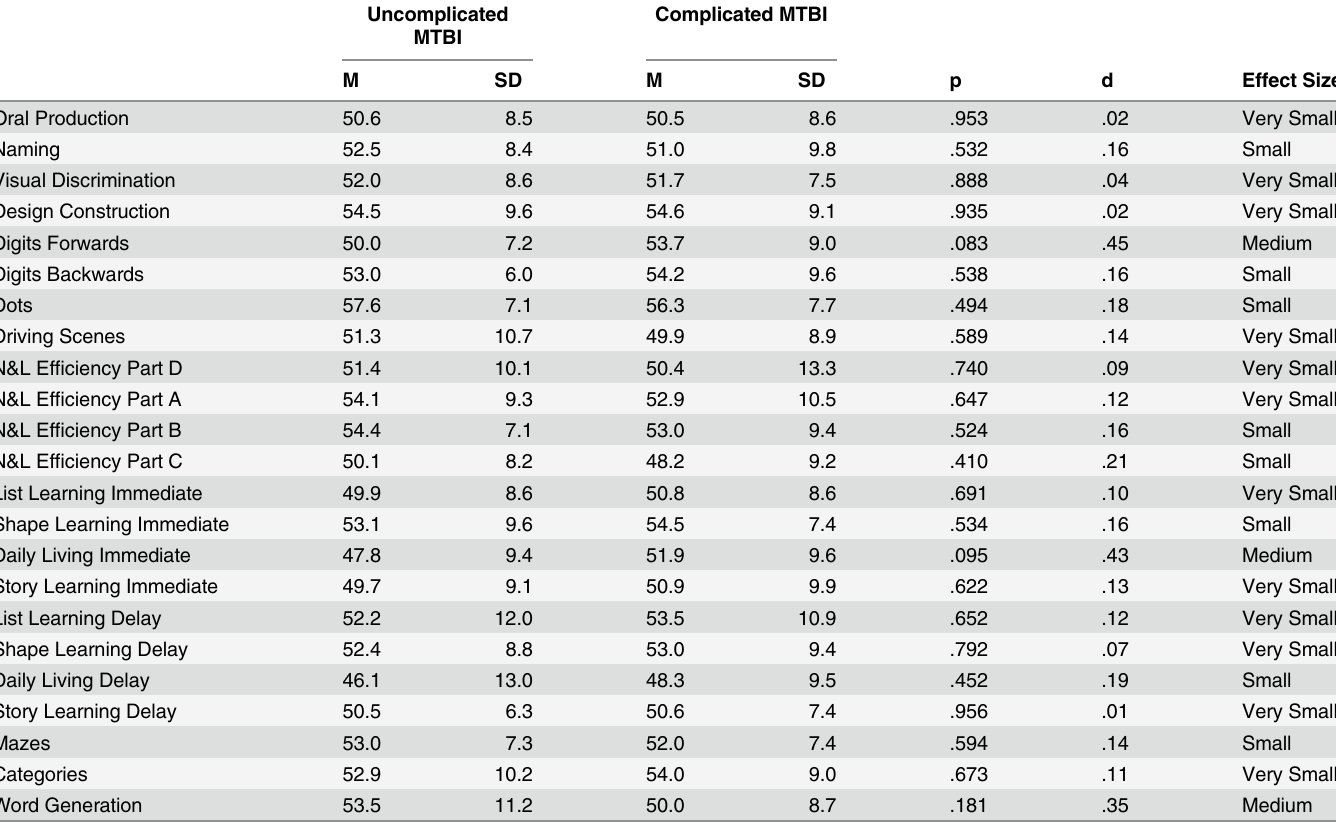
Table 5. Descriptive statistics, group comparisons, and effect sizes for individual NAB tests (demographically-adjusted T